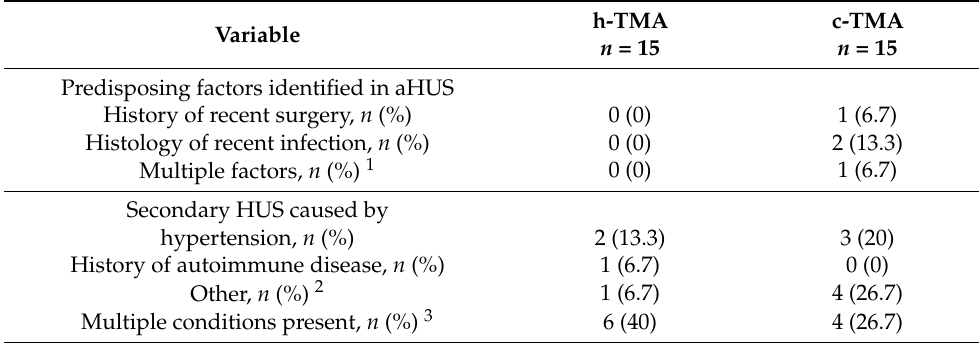
Table 2. Factors predisposing to atypical hemolytic-uremic syndrome (aHUS) and potentially causative factors for secondary HUS among patients with histological TMA (h-TMA) and clini- cal TMA (c-TMA). Values are expressed as numbers of patients (percentages in parenthesis). p -values were not significant. h-TMA c-TMA Variable n = 15